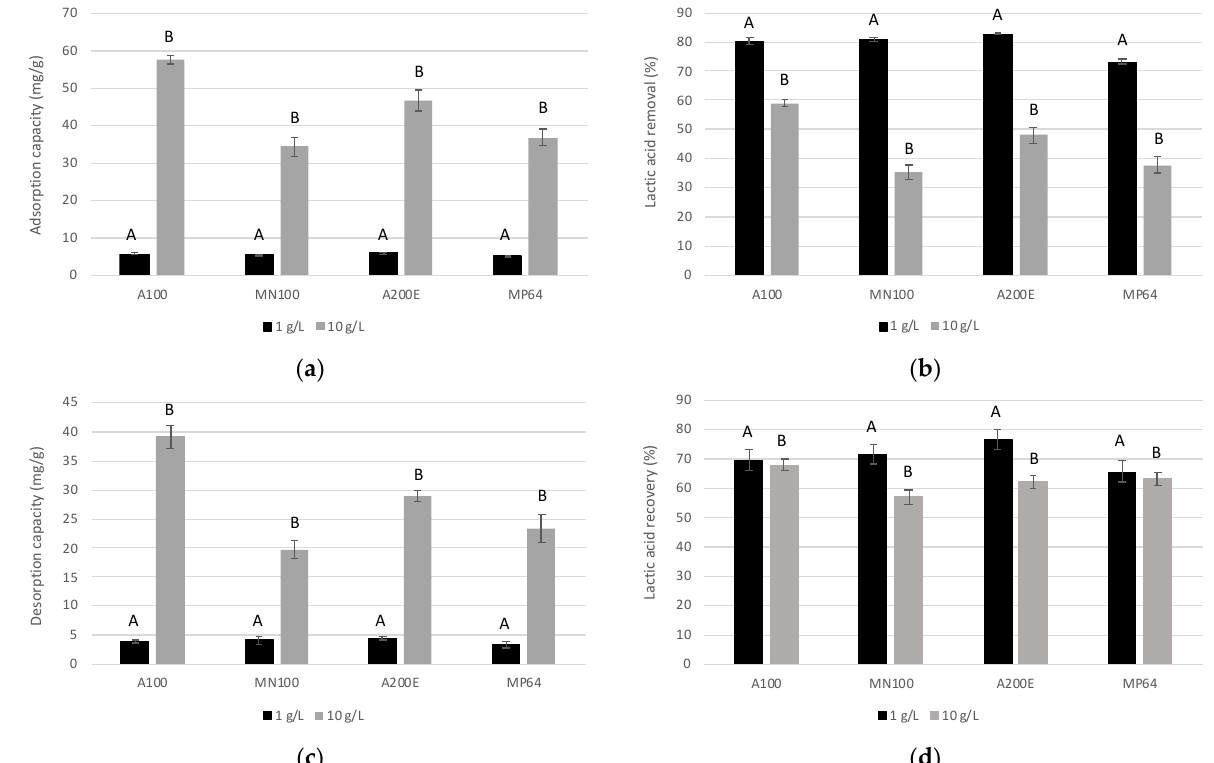
Figure 1. Resin selection based on ( a ) sorption capacity, ( b ) lactic acid removal, ( c ) desorption capacity and ( d ) lactic acid recovery at 1 and 10 g/L of initial lactic acid concentration. Di ff erent letters at the same lactic acid concentration indicate signi fi cant di ff erences ( p < 0.05).